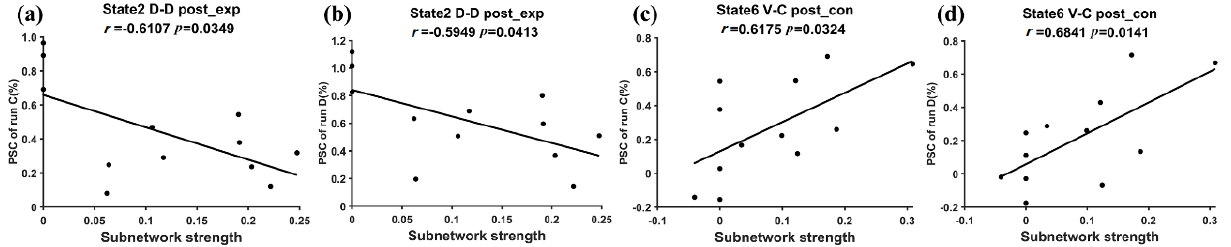
Figure 8. The relationship between the PSC of the neurofeedback runs and the subnetwork strength of the post-training run. ( a ) The significant regression relationship between the PSC of run C and the strength of D-D subnetwork for the experimental group’s state 2. ( b ) The significant regression relationship between the PSC of run D and the strength of D-D subnetwork for the experimental group’s state 2. ( c ) The significant regression relationship between the PSC of run C and the strength of the V-C subnetwork for the control group’s state 6. ( d ) The significant regression relationship between the PSC of run D and the strength of the V-C subnetwork for the control group’s state 6.